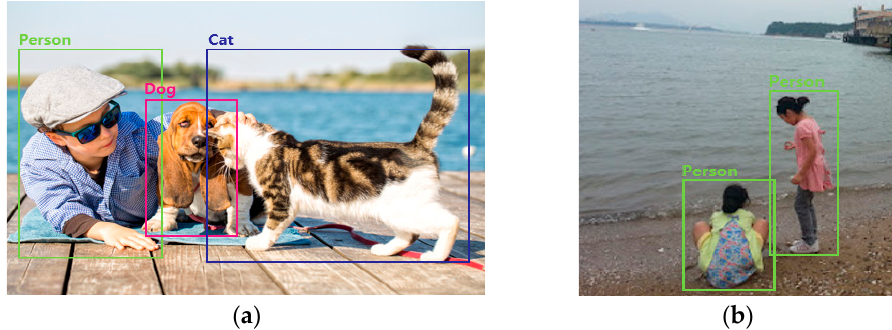
Figure 3. Problem of securing uniqueness in a group of similar objects: ( a ) individual objects; ( b ) similar objects.